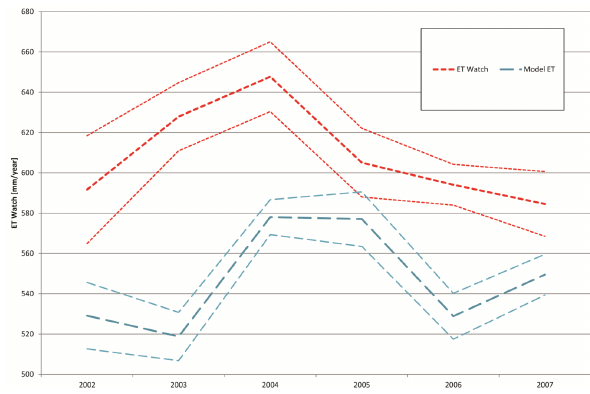
Fig.10. Simulated discharge at one representative location along the five rivers included in 1051 Fig. 10. Simulated discharge at one representative location along the model simulation. The number behind the river name represents the chainage of that 1052 the five rivers included in the model simulation. The number behind location, while the chainage of Luan River, Yongding River, Hutuo River, Zhang River 1053 the river name represents the chainage of that location, while the and Wei River are 69082 m, 206204 m, 313555 m, 430138 m and 114687 m, respectively. 1054 chainage of Luan River, Yongding River, Hutuo River, Zhang River The average areal precipitation is also plotted in the figure with simulated discharge. 1055 and Wei River are 69082m, 206204m, 313555m, 430138m and 114687m, respectively. The average areal precipitation is also plot- ted in the figure with simulated